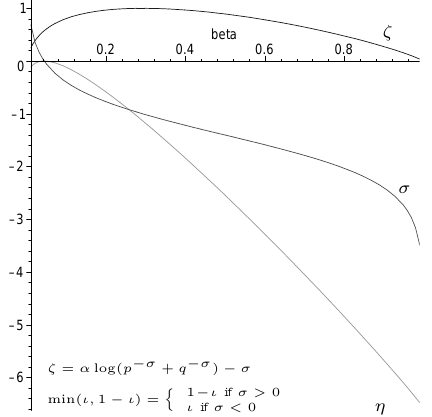
Fig. 4: Minimum ordinate of perturbation ρ . See Def- inition 2 and Theorem 2. The perturbation is at most O ( e − ρ ) times the dominant part of the integral. Remark that e − 11 < 2 × 10 − 5 .